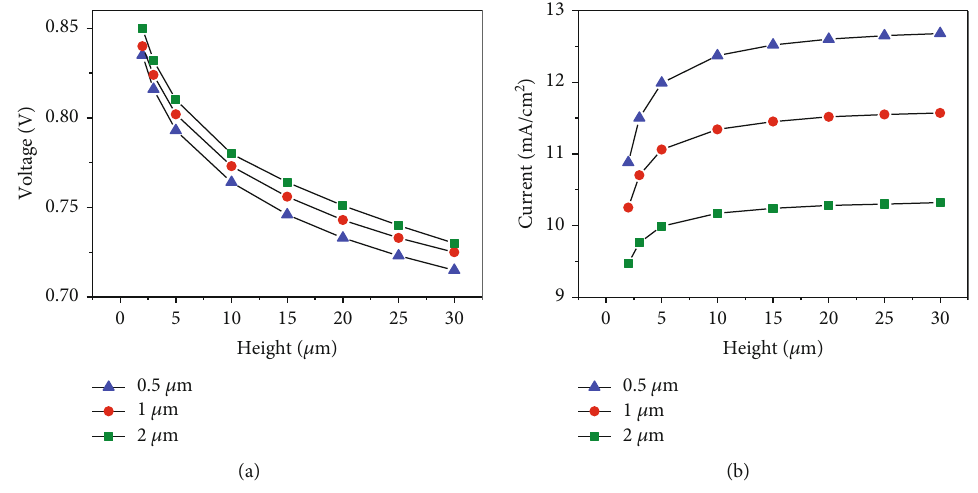
Figure 7: Calculated values of (a) V OC and (b) J SC for the top junction created on the wire of various diameters and heights. 1.451.501.551.601.65